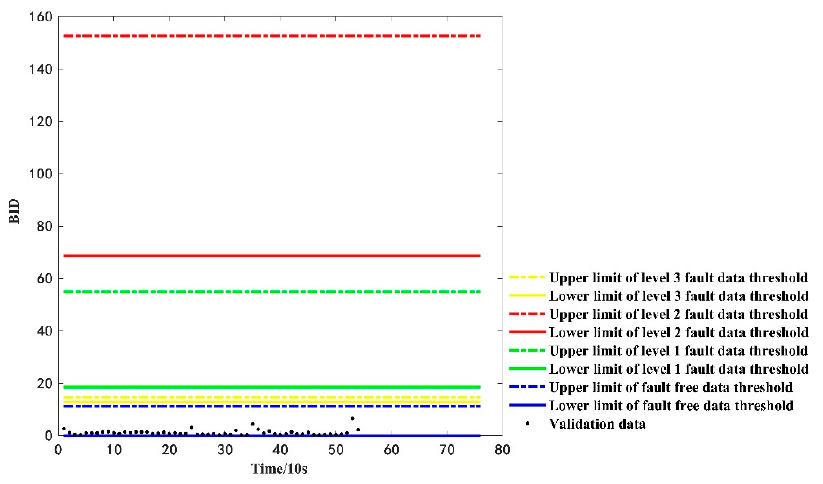
Figure 11. The discrimination results of the verified faults-free data.